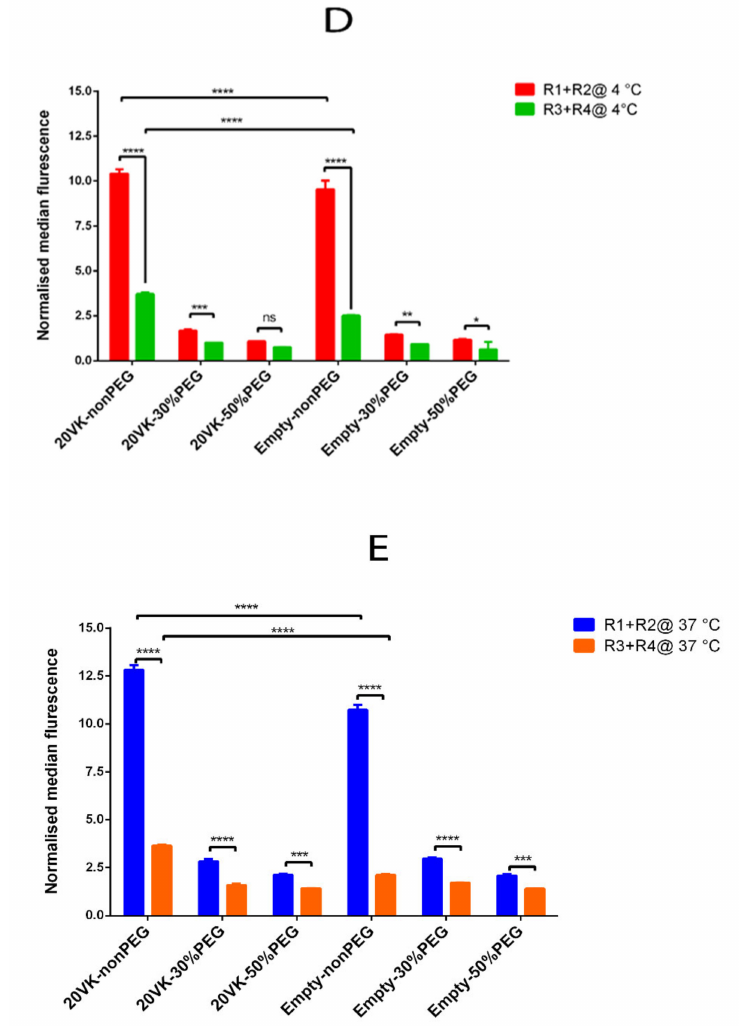
Figure 4. FACS analysis of Hela cells showing SR-B1/GFP fluorescence ( Y -axis) and rhodamine fluorescence ( X -axis): ( A ) non-transfected (left) and transfected (right) Hela cells not exposed to mixed micelles; ( B , C ) incubation of transfected cells, with from top to bottom: non-PEGylated, 30%-PEGylated and 50%-PEGylated mixed micelles (1.58 mM lipid) labeled with rhodamine, without (empty) or with vitamin K loading (350 µ M) at 4 ◦ C ( B ), and at 37 ◦ C ( C ). R1 + R2: Hela cells with SR-B1/GFP signal, R3 + R4: Hela cells without SR-B1/GFP signal; ( D , E ) quantification of corresponding fluorescence of rhodamine for transfected HeLa cells incubated with micellar formulations, data shown as mean ± SD, n = 3. The quantified fluorescence intensity was normalized for the intensity from 20VK-50PEG micelles in cells without SR-B1/GFP. (Two-way ANOVA, **** p < 0.0001, *** p < 0.001, ** p < 0.01, * p < 0.05, ns is not